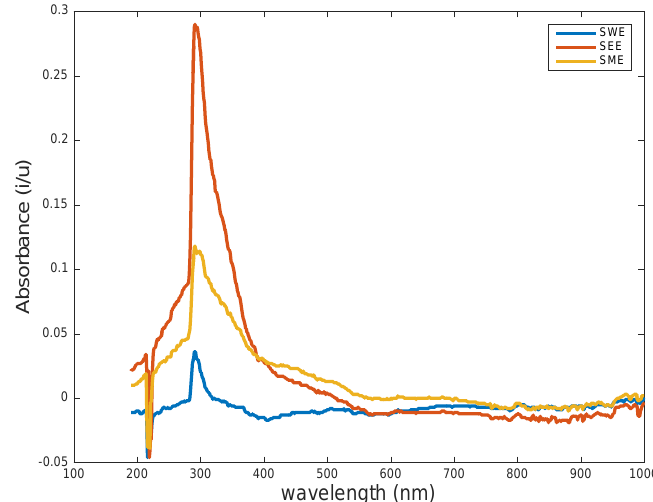
Figure 3. UV-VIS profile for the seed water extract (SWE), seed ethanol extract (SEE), and seed methanol extract (SME) revealed intense peaks all centered around 293 nm. The SWE also indicated the least peak intensity, implying a low extraction efficiency with water.